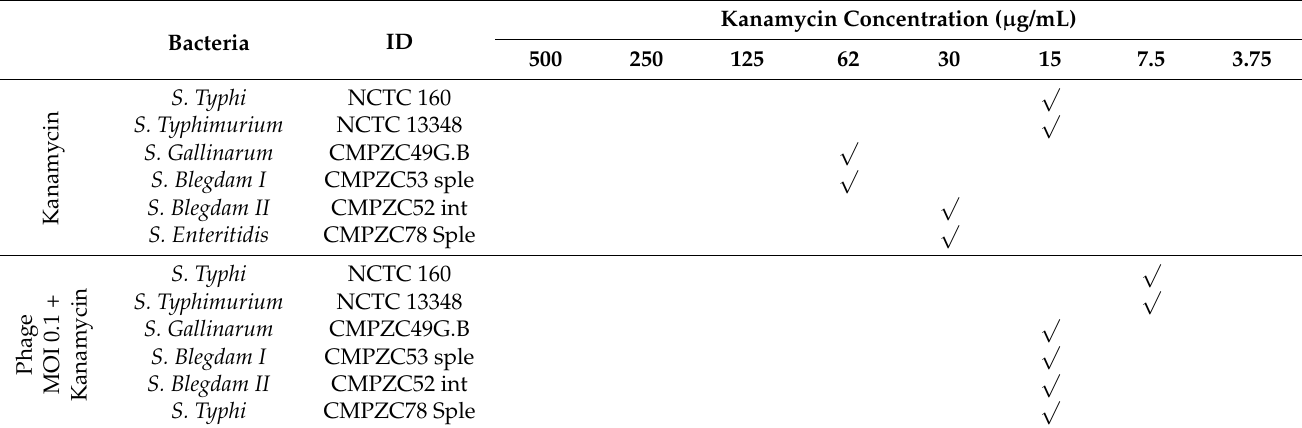
Table 2. The MIC of different bacteria against kanamycin alone and with